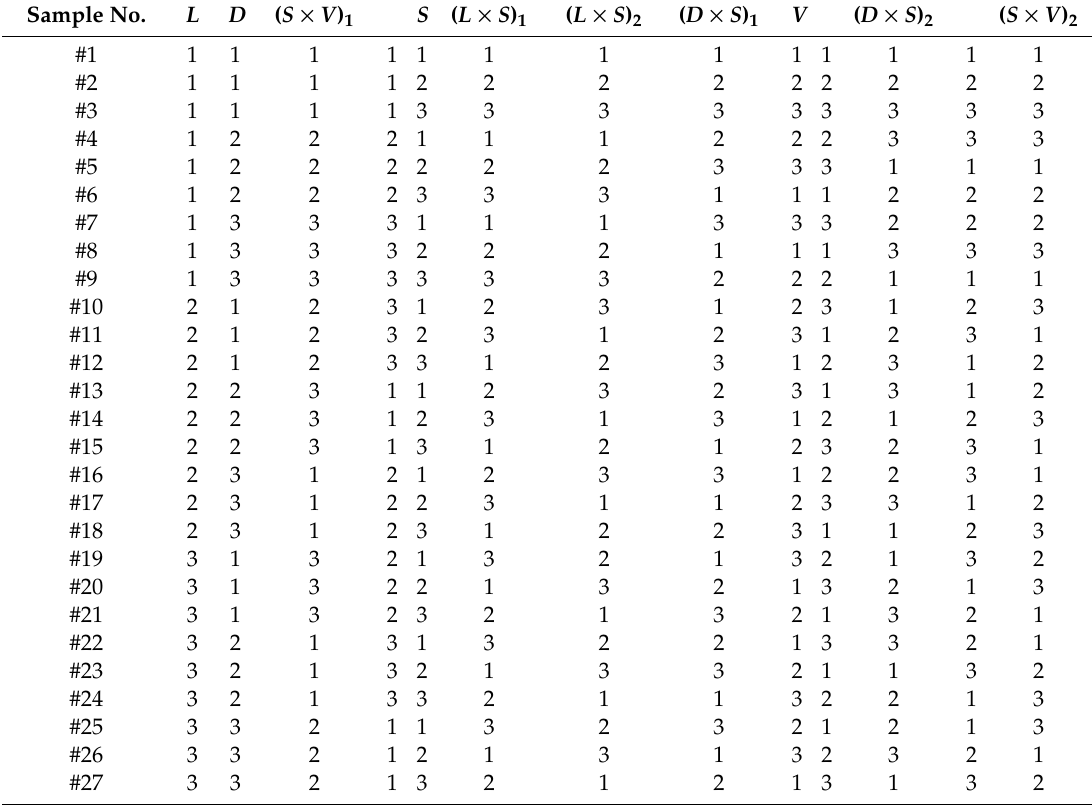
Table 2. L 27-(3 13 ) orthogonal table for preparation of Ti(C, N) ceramic coating by laser cladding. Sample